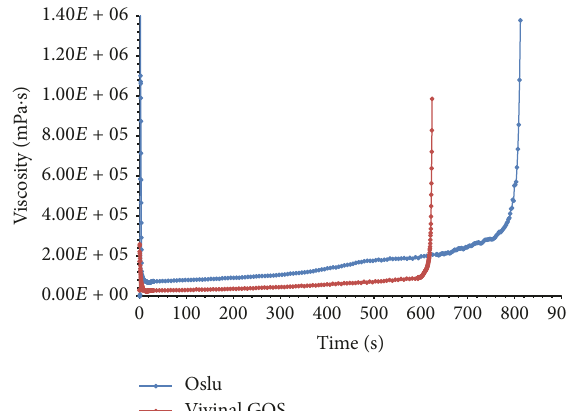
Figure 3: Variation of viscosity with time at constant shear rate (10s −1 ) and temperature (25 ∘ C).